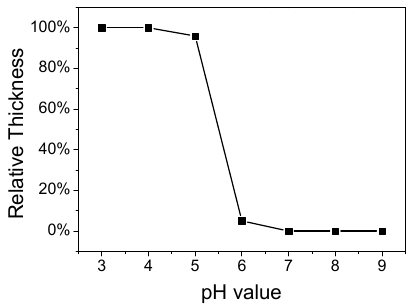
Figure 6. Decomposition of the film in different pH value solution in 6 h. (The original films are fabricated: PEOX, M w 50,000, 1 mg/mL; PAA, M w 450,000, 1 mg/mL; pH 2.0; assembling time, 4 min; rinsing time, 1 min; and room temperature).